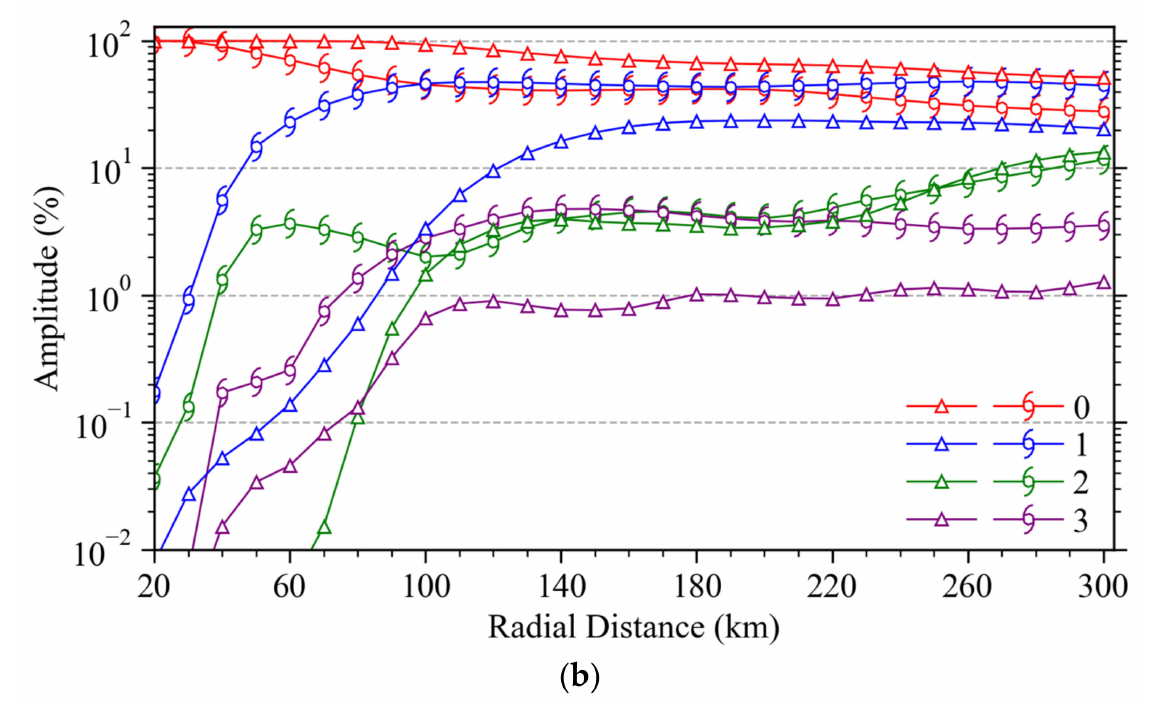
Figure 12. ( a ) Spatial distribution of ABI channel 13 TB observations (color shading; unit: K) around Hurricane Jose at 1000 UTC September 11, 2017. The ABI-determined center (magenta open triangle), the best track center (cyan hurricane symbol), the R IR (blue circle), and R OR (black circle) are also indicated. ( b ) Radial variations of the azimuthal wavenumbers 0–3 amplitude percentages (solid curves; %) with the ABI-determined center (open triangle) and best track (hurricane symbol) as assumed by Jose’s centers at about 1000 UTC September 11,